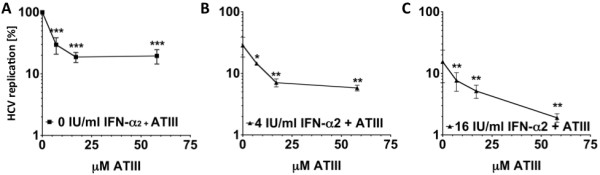
Additive effect of simultaneous ATIII and IFN-α treatment on HCV replication. (A) Effect of ATIII treatment alone on HCV replication. Significant inhibition is indicated as asteriks in compare to vehicle treated control (***, P<0.001, one-table T-test, n=6). (B) Additive effect of ATIII on 4 IU/ml IFN-α2 treatment (n=3). (C) Additive effect of ATIII on 16 IU/ml IFN-α2 treatment (n=3). Luciferase expression in HCV OR6 replicon cells was used as an indicator of HCV replication after treatment with IFN-α2 and/or ATIII. 5x104 HCV OR6 replicon cells were treated with different concentrations of IFN-α2 and ATIII. Residual luciferase activity as percentage of the vehicle treated control was used to quantify HCV replication. The additive effect of ATIII (7, 17, 58 μM) on different concentrations of IFN-α2 (in B and C) is shown by significant decrease (*, P<0,05; **, P<0.01; *** P<0.001, unpaired T-test) in residual luciferase activity in compare to inhibition of IFN-α2 starting concentration (4, 16 IU/ml without ATIII treatment). Error bars represent standard error of the mean.